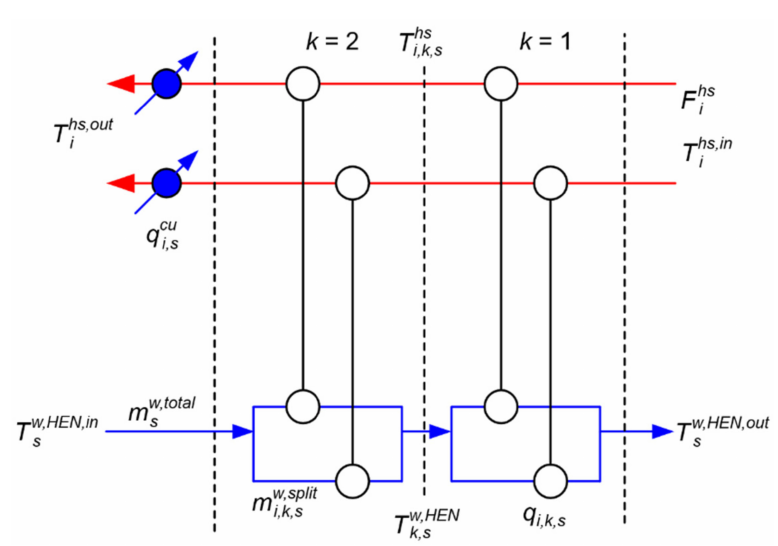
Figure 3. The stage-wise